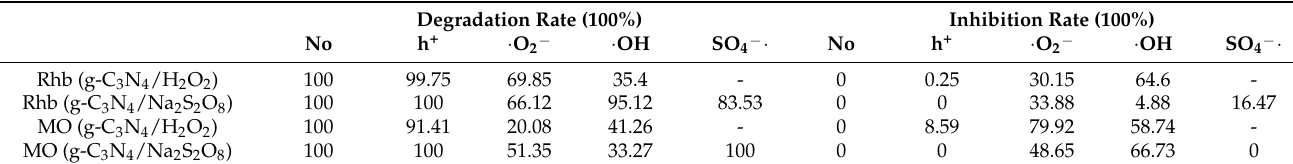
Table 5. Free radical capture control situation.